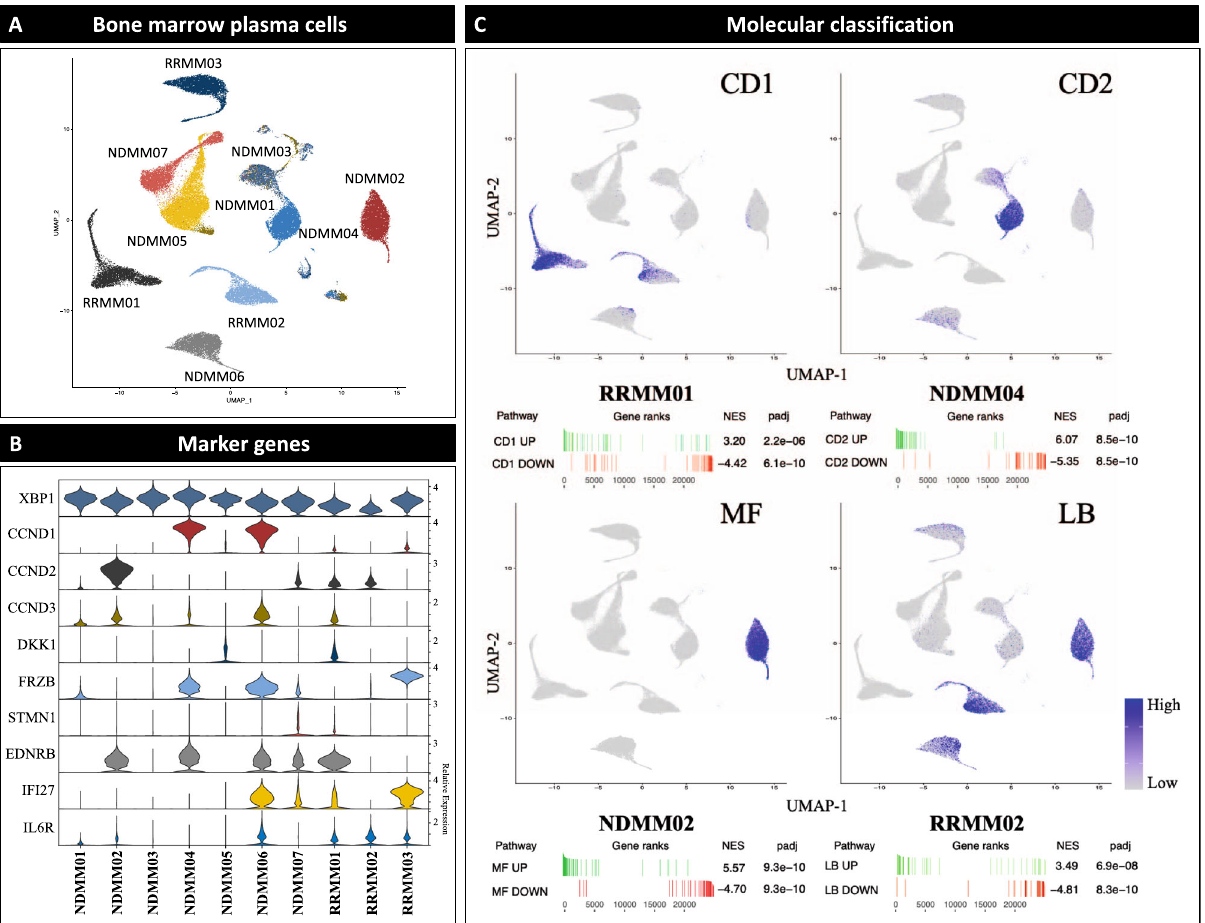
Fig. 3 Single cell RNA sequencing demonstrates inter-patient heterogeneity and identi fi es molecular subgroups of multiple myeloma. A To further characterize inter-patient heterogeneity based on scRNA-seq of bone marrow plasma cells (PC) we identi fi ed marker genes for the patient-speci fi c single PC clusters. B Violin plots showing the identi fi ed marker genes for each individual patient. The width of the violin representing the number of cells expressing the respective gene with the relative expression being plotted on the y-axis. XBP1 was included in the top row as positive control to show the extend of the entire PC population. CCND1-3 were marker genes in patients with IgH-translocations (NDMM02/04/06) and homogeneously expressed in all PC. Other marker genes associated with bone disease ( DKK1 , FRZB ), cytokine signaling ( IFI27 , IL6R ) and EDNRB have been described in bulk gene expression pro fi ling (GEP) studies. C Gene set enrichment analysis (GSEA) to classify patients according to the molecular subtypes published by the Arkansas group 18 . Gene sets are available in the Molecular Signature Database (MSigDB). Examples are shown for the subgroups CD1 (RRMM01), CD2 (NDMM04), MF (NDMM02) and LB (RRMM02). GSEA for up- (green lines) and downregulated genes (red lines) were performed. The AddModuleScore() command from Seurat was used to calculate the average expression for the top 50 upregulated genes in the molecular subcategory and visualize fi ndings in a FeaturePlot. Relative expression levels ranged from low (in gray) to high (in purple). ScRNA-seq characterized inter-patient heterogeneity and classi fi ed individual patients based on their single PC transcriptomes into molecular subgroups of multiple myeloma. NES = normalized enrichment score. Padj = adjusted p -value estimation based on an adaptive multi-level split Monte-Carlo